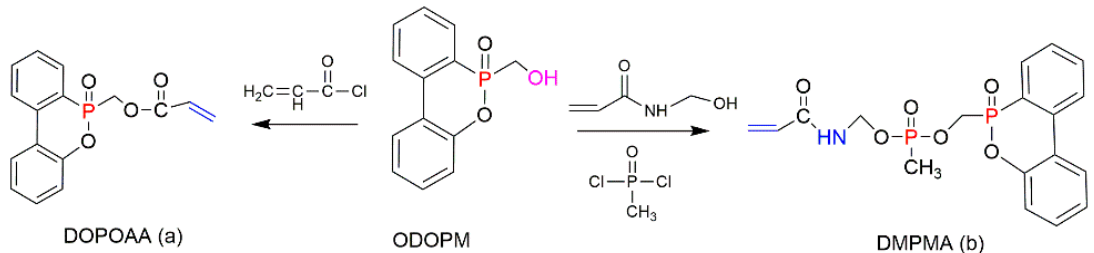
Figure 21. Syntheses of different DOPO derivatives from ODOPM precursor [48,113].